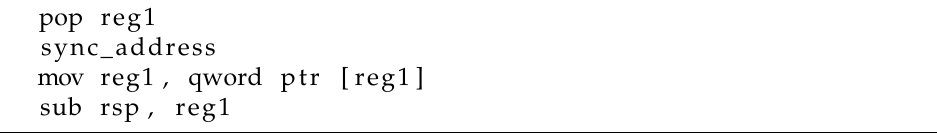
( c ) After executing gadget.